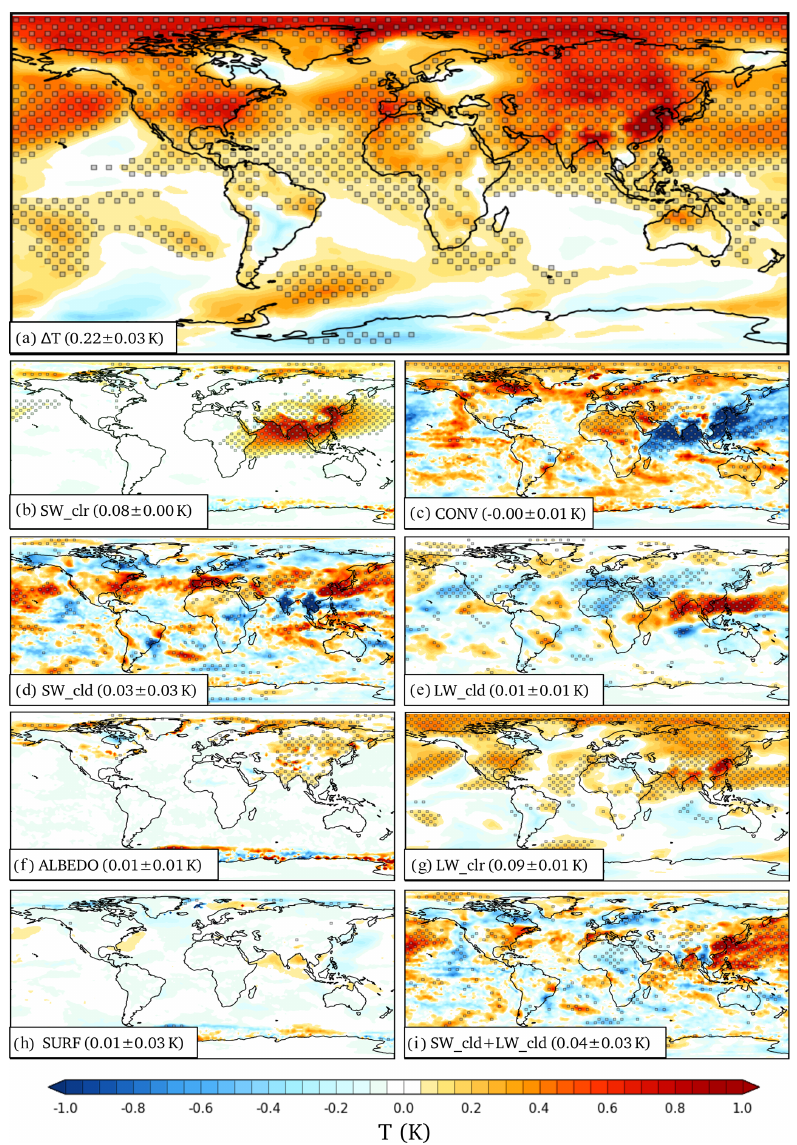
Figure A2. The geographical distributions of annually averaged surface air (2m) temperature responses due to the removal of South and East Asian aerosols for ECHAM6.1. Brackets show global averages. (a) The total surface response. (b–h) Contributions to the total surface temperature response from shortwave clear-sky response (b) , horizontal atmospheric heat transport (c) , shortwave cloud response (d) , long- wave cloud response (e) , surface albedo change (f) , longwave clear-sky response (g) , and surface energy flux change (h) . (b–h) Sum up to the response seen in panel (a) . Panel (i) shows the combined shortwave and longwave cloud